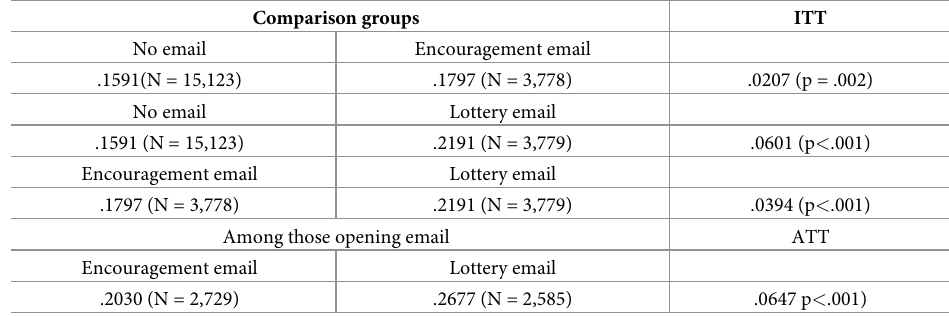
Table 1. Treatment effect calculations for encouragement and lottery email